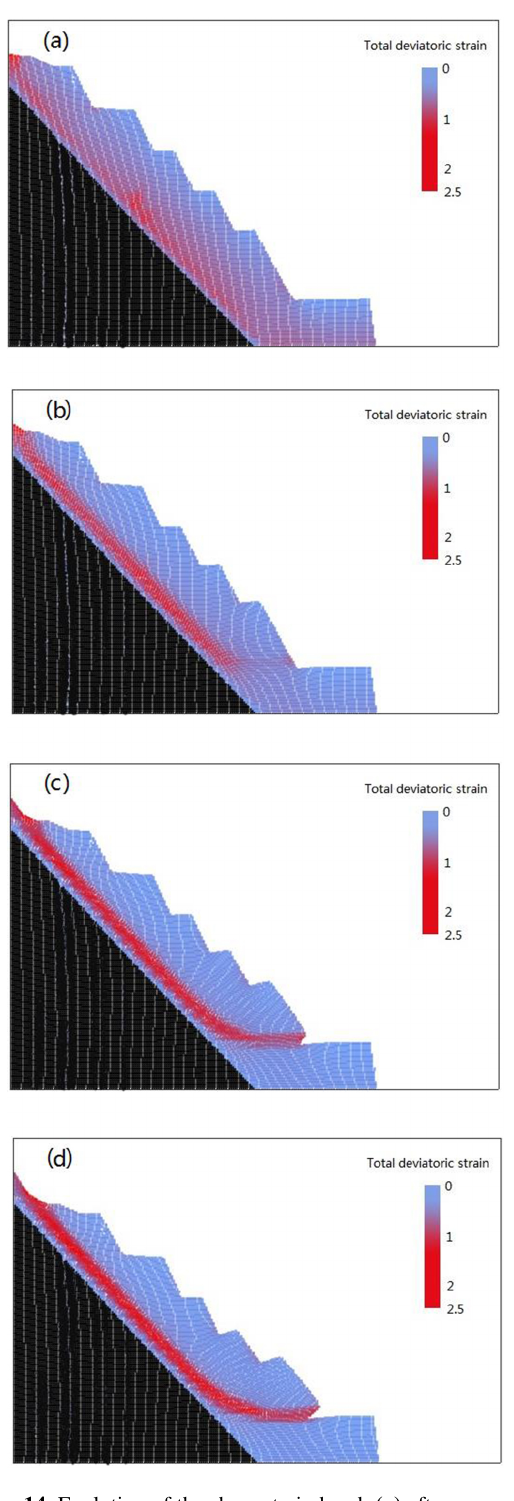
Figure 14. Evolution of the shear strain band: (a) after excavation; (b) global failure, D 2 W norm = 0; (c) slip configuration after 5s; and (d) slip configuration after 7s.